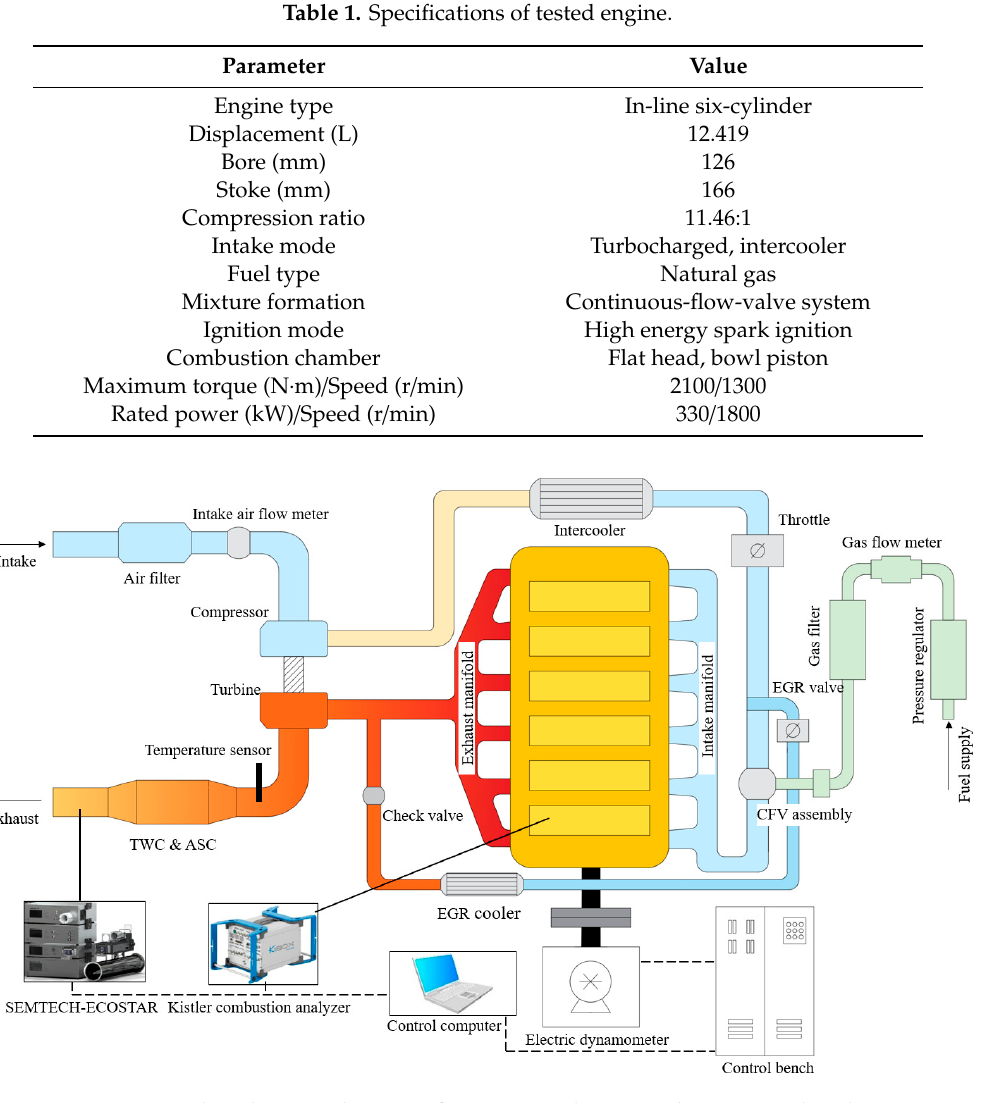
Figure 1. The schematic diagram of experimental setup and engine test bench.